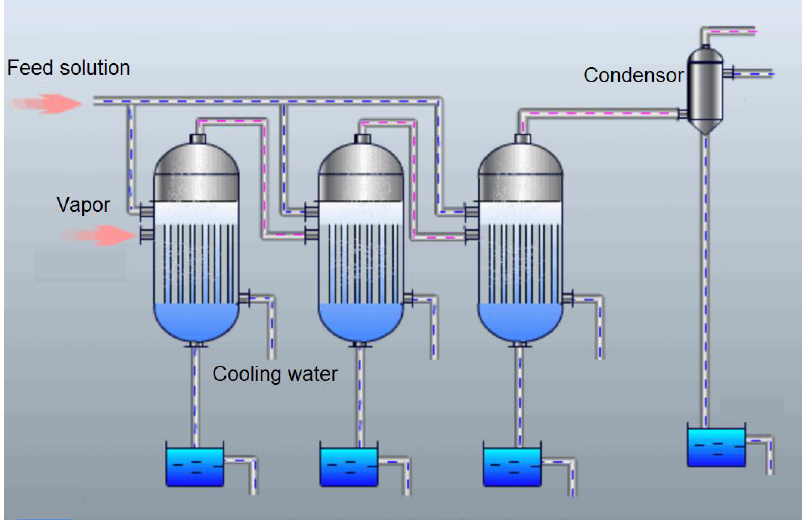
Figure 4. Solubility curves of CoSO 4 , MnSO 4 , NiSO 4 and Li 2 SO 4 in H 2 O (solubility data based on literature reports [46]).